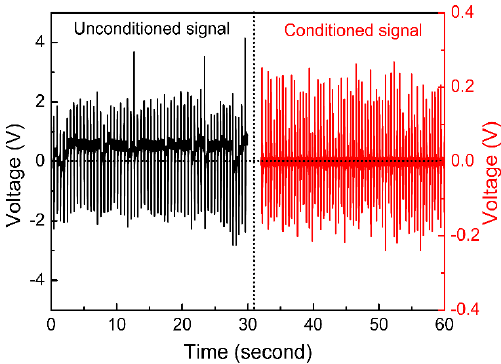
Figure 6. Comparison of recorded voltage signals generated by the NaNbO 3 sensors with and without signal conditioning.